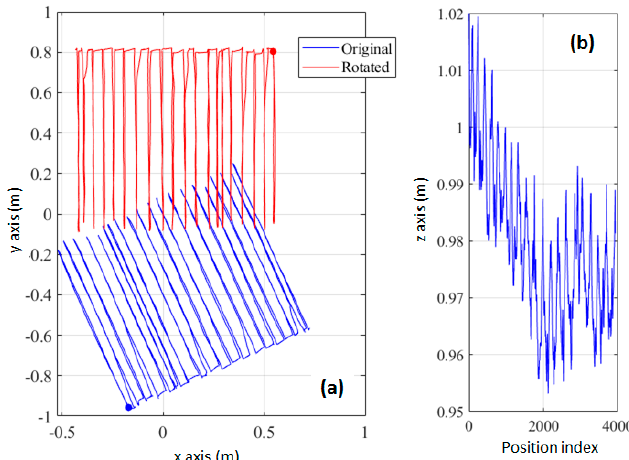
Figure 5. Example of measured Real Time Kinematics (RTK) positions for a single 2D acquisition grid with the portable setup. XY plane before (blue) and after (red) coordinate system transformation ( a ). Height above ground for each measurement position ( b ).